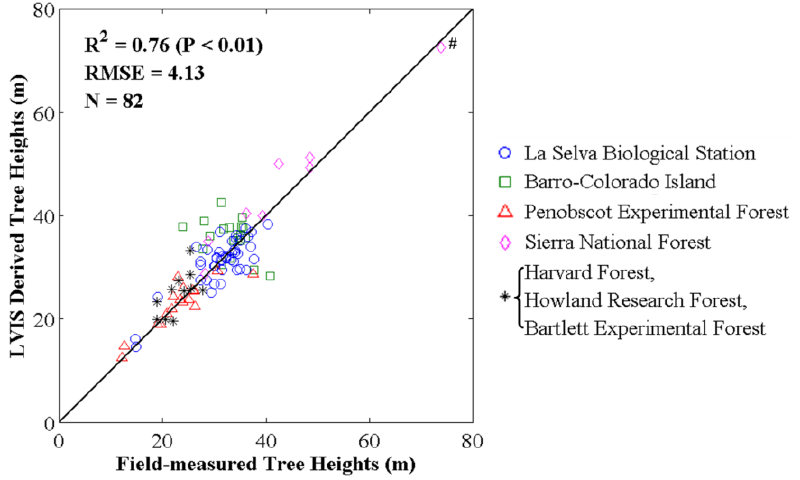
Figure 4. Comparison of LVIS tree heights with field measurements. A total of 82 plots from seven different sites are considered in this analysis. Regression analysis indicates a statistically significant relationship between LVIS tree heights and field measurements (p < 0.01). # In Sierra National Forest, there is one extremely influential observation due to old growth forests (ages > 150;